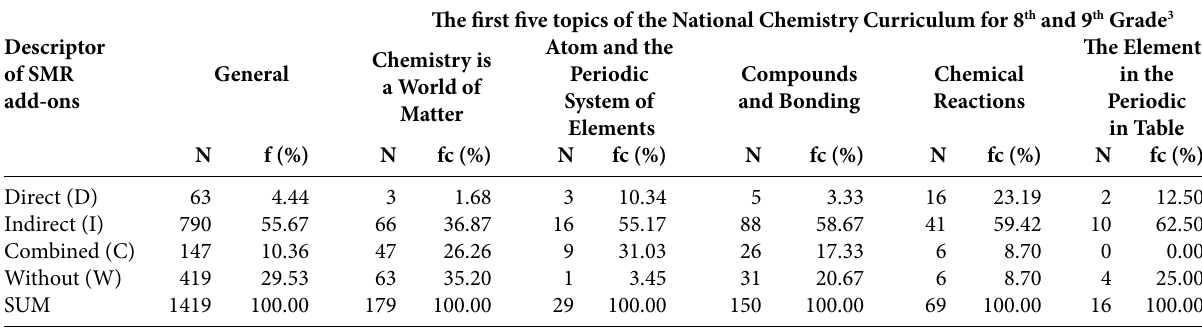
Table 4. The proportion of SMRs within the particular topics of the textbook sets – part 1 The first five topics of the National Chemistry Curriculum for 8 th and 9 th Grade 3